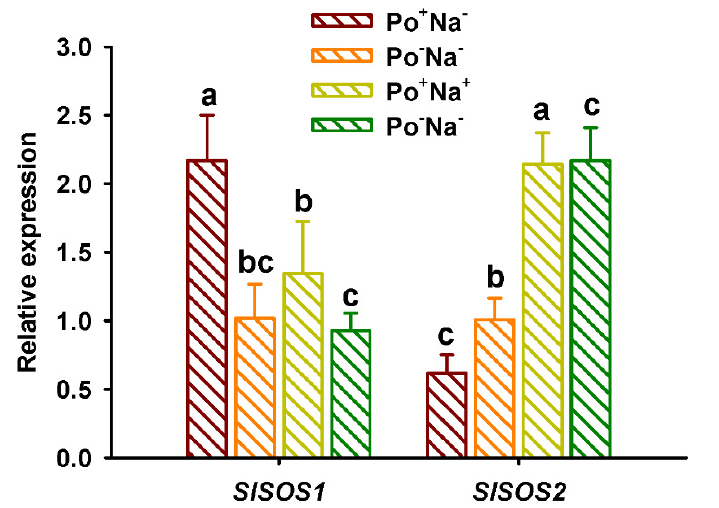
Figure 5. Changes in leaf SlSOS1 and SlSOS2 expressions of tomato plants colonized by Paraglomus occultum under 0 and 150 mM NaCl stress. Data (means ± SD, n = 3) followed by different letters on the bar indicate significant differences among treatments at the 0.05 level. See Table 1 for abbrevia- tions.